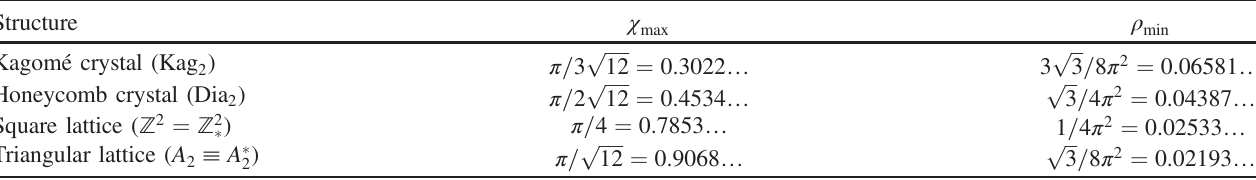
(smallest possible value of ρ ) corresponds to the triangular lattice. max min